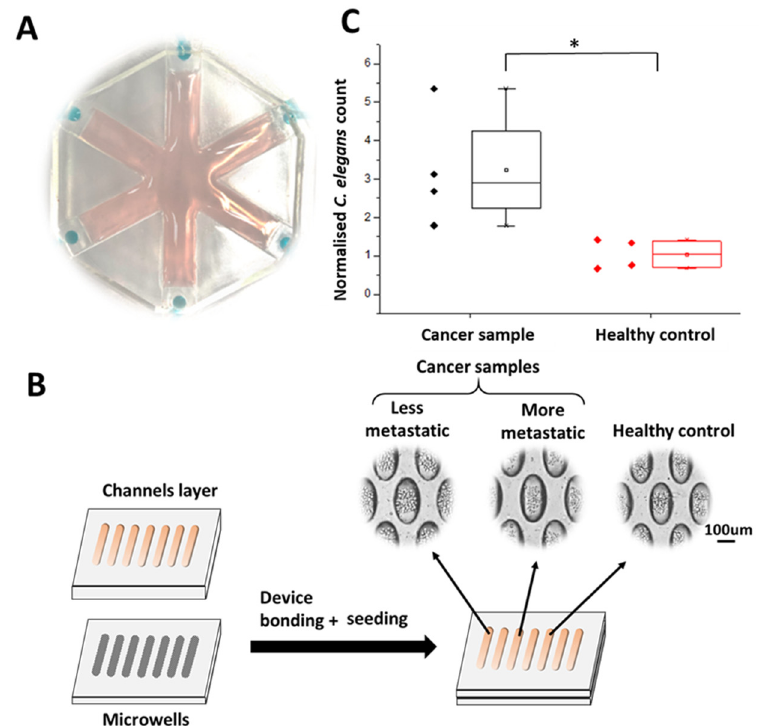
Figure 2. Characterization of the WB biosensor. ( A ) A representative image of the multiplexed WB biosensor for parallel screening. ( B ) Schematics of the device and workflow used to generate samples from cancer cell clusters within 48 h. ( C ) Box plot reflecting the chemotactic preference of worms with the WB biosensor for less metastatic cancer samples (MCF-7) and healthy controls (fibroblast). Worm counts were normalized to those obtained with PBS buffer standards. * states for p values < 0.05.